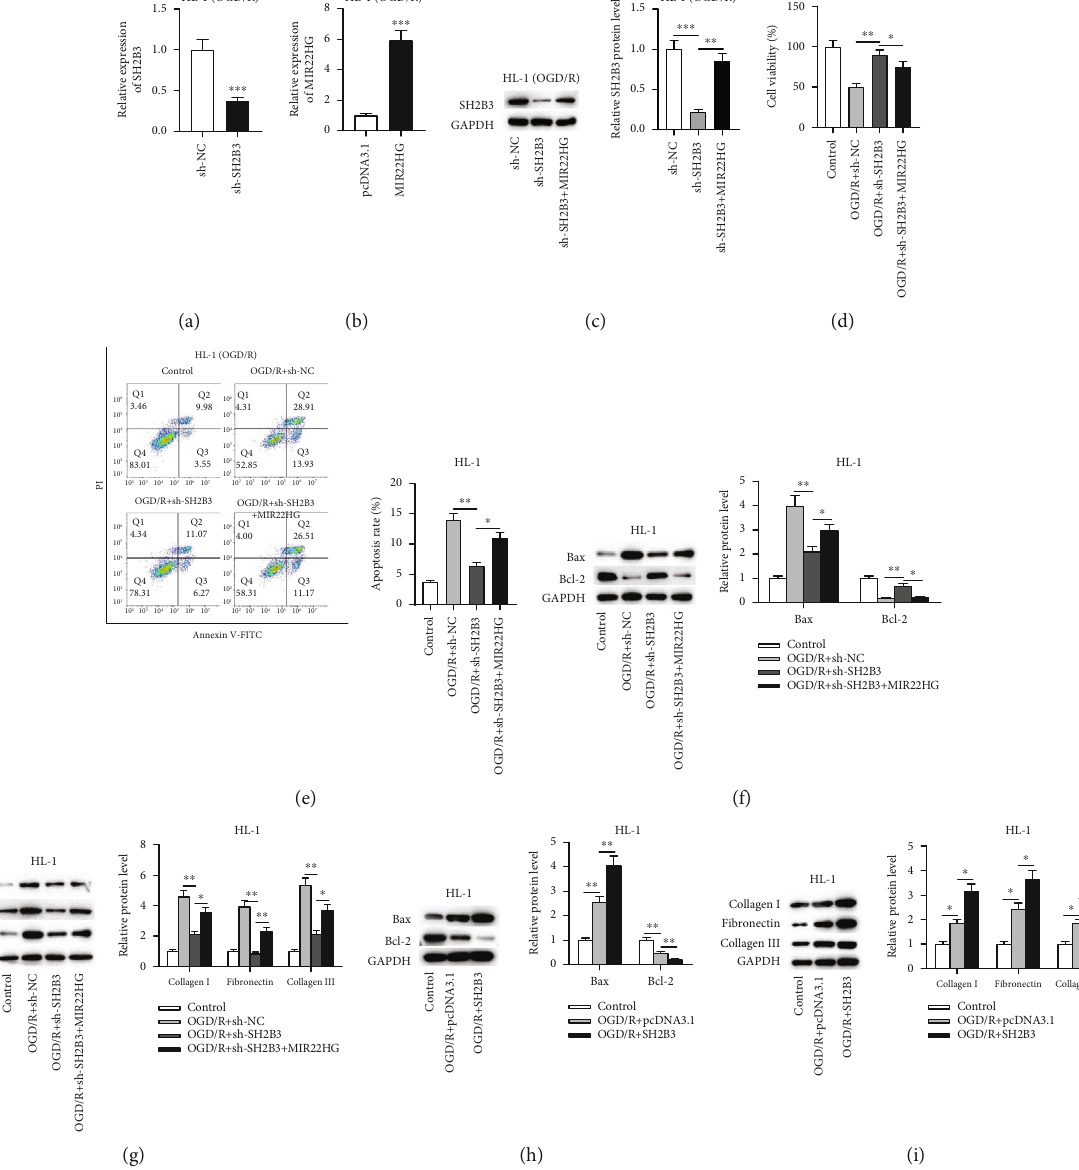
Figure 5: MIR22HG overexpression reverses the e ff ect of SH2B3 knockdown in OGD/R-treated HL-1 cells. (a) The knockdown e ffi ciency of sh-SH2B3 was examined by RT-qPCR ( n = 3 ). (b) The overexpression e ffi ciency of pcDNA3.1/MIR22HG was tested by RT-qPCR ( n = 3 ). (c) The protein level of SH2B3 in each group was measured by western blotting ( n = 3 ). (d) The cell viability in each group was assessed by CCK-8 assay ( n = 3 ). (e) The cell apoptosis in each group was determined by fl ow cytometry analysis ( n = 3 ). (f – i) The protein levels of Bax, Bcl-2, collagen I, fi bronectin, and collagen III in OGD/R-treated HL-1 cells transfected with di ff erent vectors were measured by western blotting analysis ( n = 3 ). ∗ p < 0 : 05 , ∗∗ p < 0 : 01 , ∗∗∗ p < 0 : 001